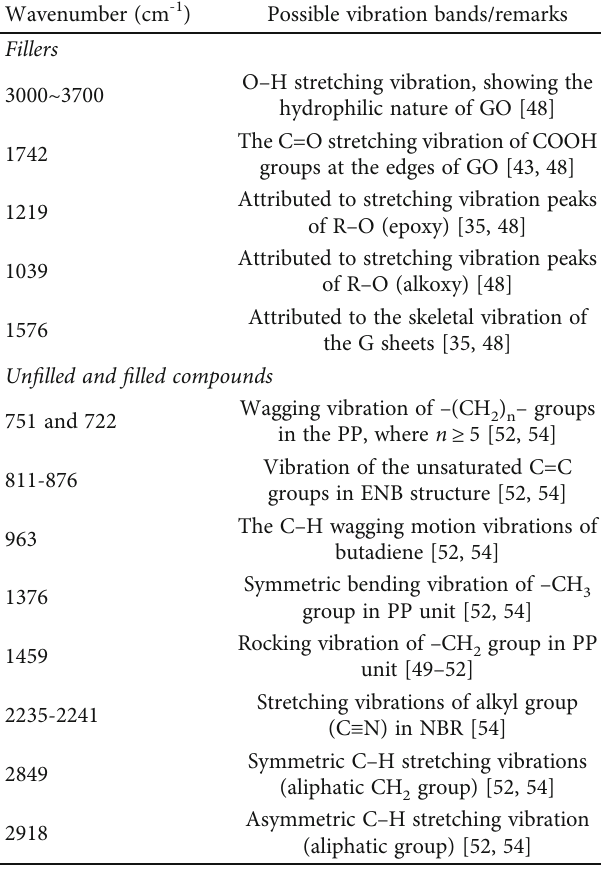
Table 2: FTIR spectra of fi llers, pure matrices, the blends, and their composites with the fi